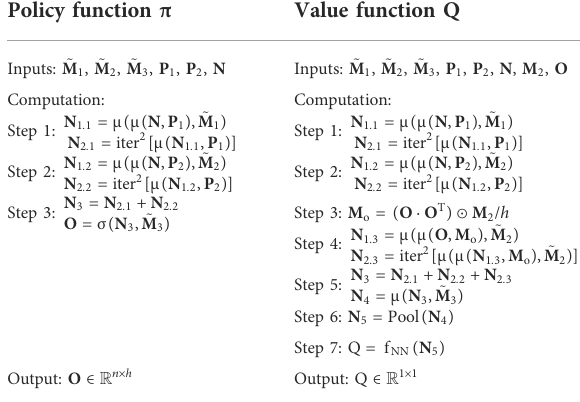
TABLE 1 Policy and value functions of GCN-DDPG for bracing direction optimization. Policy function